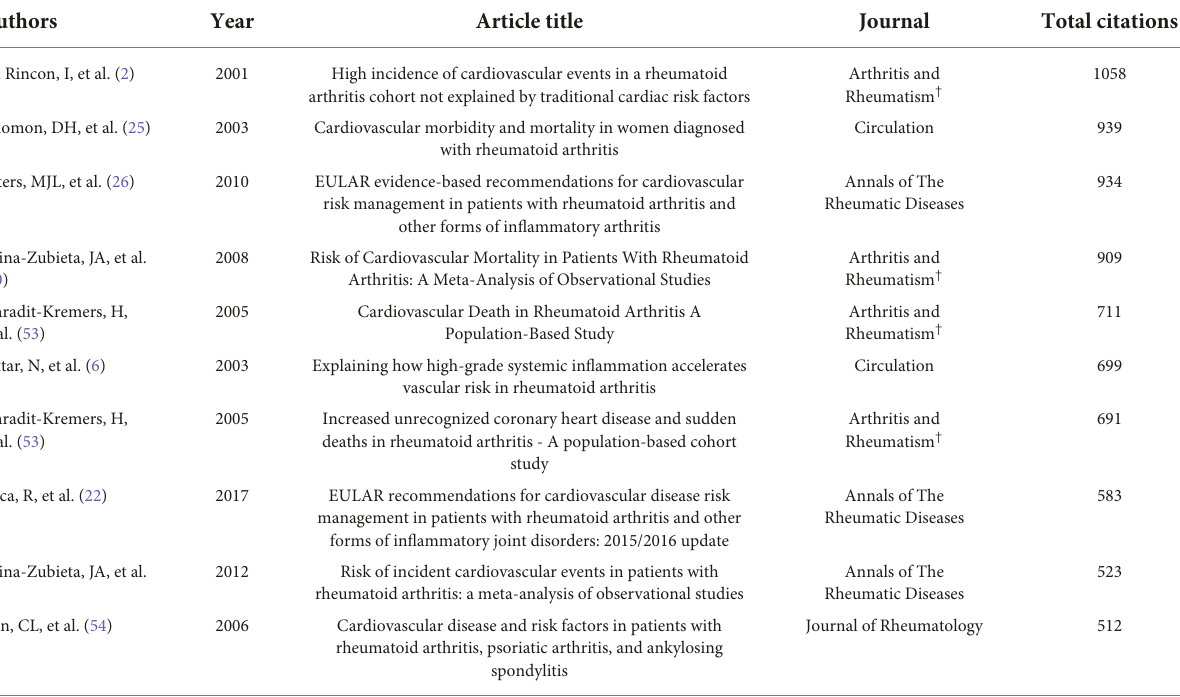
TABLE 4 Top 10 high-cited articles on rheumatoid arthritis-related cardiovascular disease.